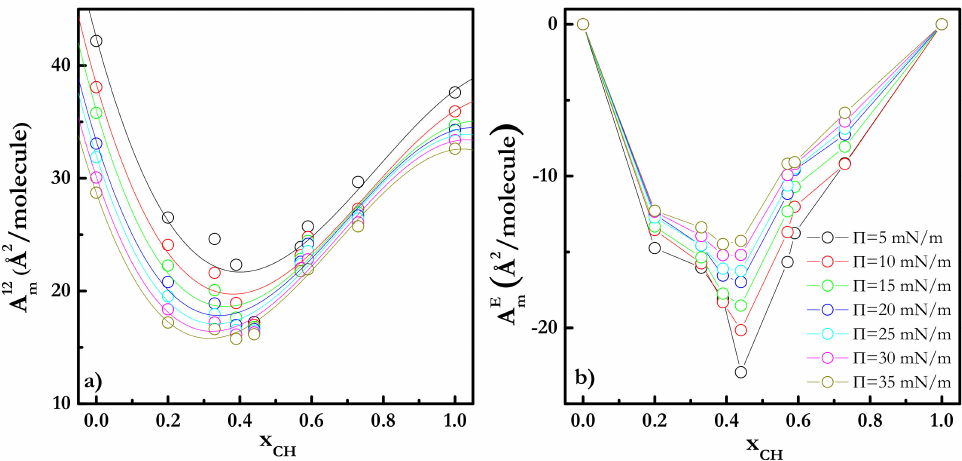
Figure 3. ( a ) Dependences of the experimental average areas per molecule on x CH for binary mixtures of CH and CS spread at the water/vapor interface at different surface pressures at 24 ◦ C. ( b ) Dependence of the average excess area per molecule on x CH for Langmuir monolayers of mixtures of CH and CE spread at the water/vapor interface at different surface pressures at 24 ◦ C. In both panels, the lines are guides for the eyes and the color guide is the